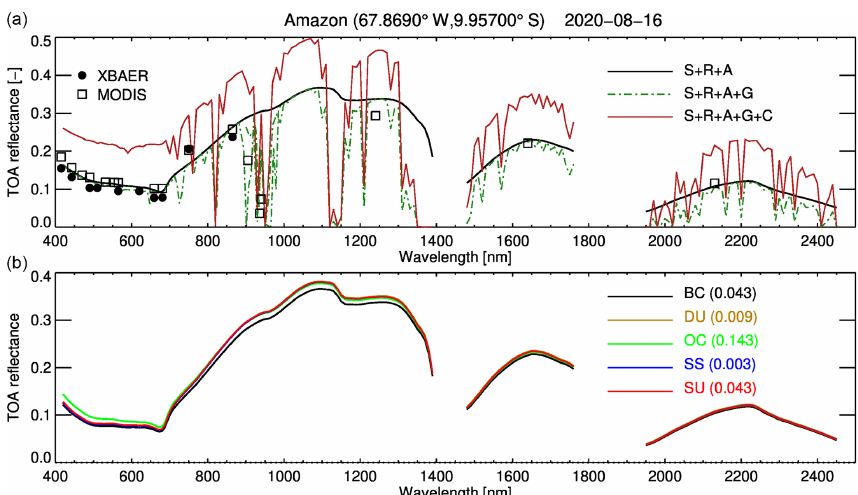
Figure 4. TOA reflectance simulation for a measurement from the EnMAP instrument over the Amazon region on 16 August 2020. (a) TOA reflectance simulated using different settings: S – surface reflectance described by the PROSAIL model, R – Rayleigh, A – aerosol, G – gaseous absorbers, C – cloud. Open rectangles depict MODIS observation data, and filled circles represent simulations with XBAER for OLCI wavelengths. (b) TOA reflectance simulated considering different MERRA aerosol components: BC – black carbon, DU – dust, OC – organic carbon, SS – sea salt, SU – sulfate. The AOT for each component is indicated in the